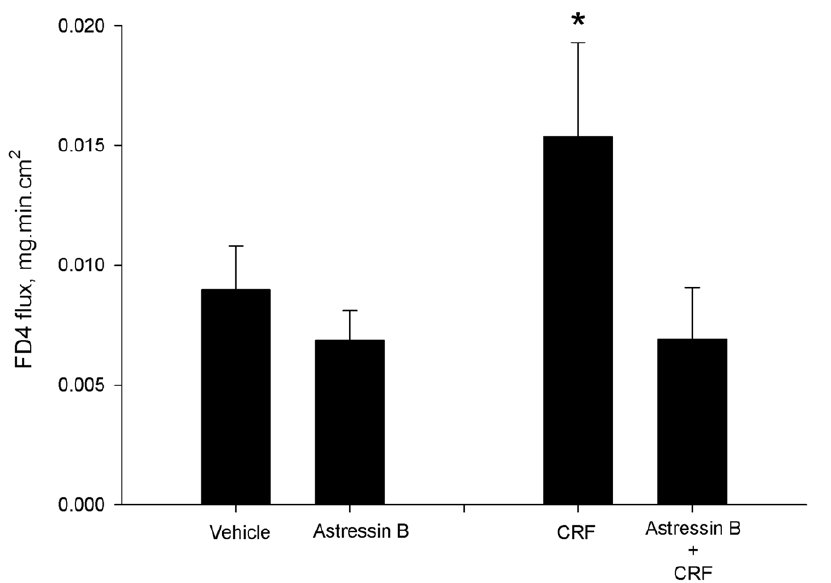
Figure 2. CRF-induced FD4 flux is Prevented with Astressin B. CRF (0.5 m M) induced elevations in the rate of FD4 flux across the porcine ileum mounted on Ussing chambers. Pre-treatment of ileal mucosa with Astressin B (1 m M) 30 minutes prior to CRF exposure prevented CRF-mediated increases in FD4 flux rates. Data for each experimental treatment are expressed as means 6 SE for n=6 2 8 pigs. Symbols (*, { ) differ from other treatments by p , 0.05; ANOVA.